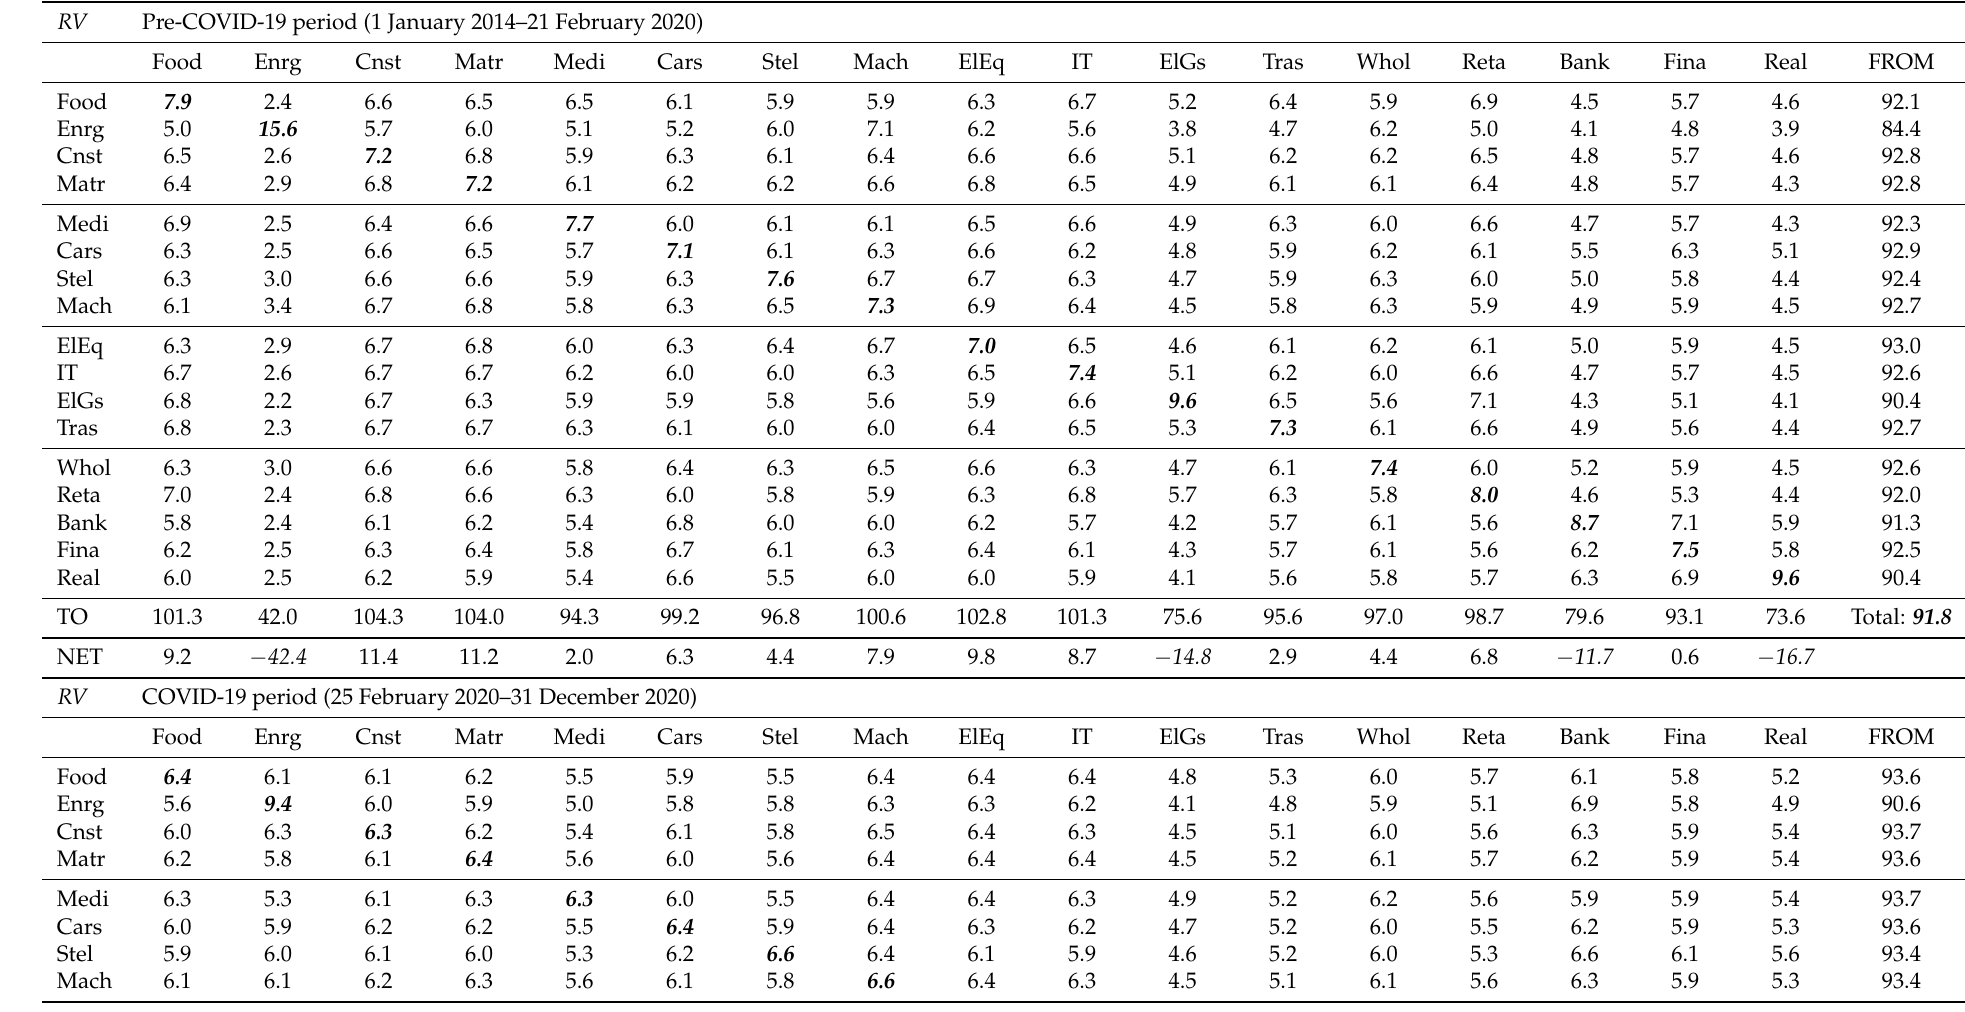
Table 3. Total spillover table based on realized volatility during pre-COVID-19 and COVID-19